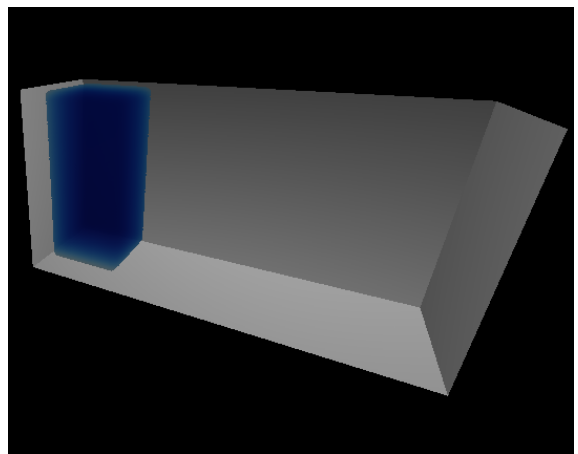
Fig. 17: Simulation state at 0 . 0 s